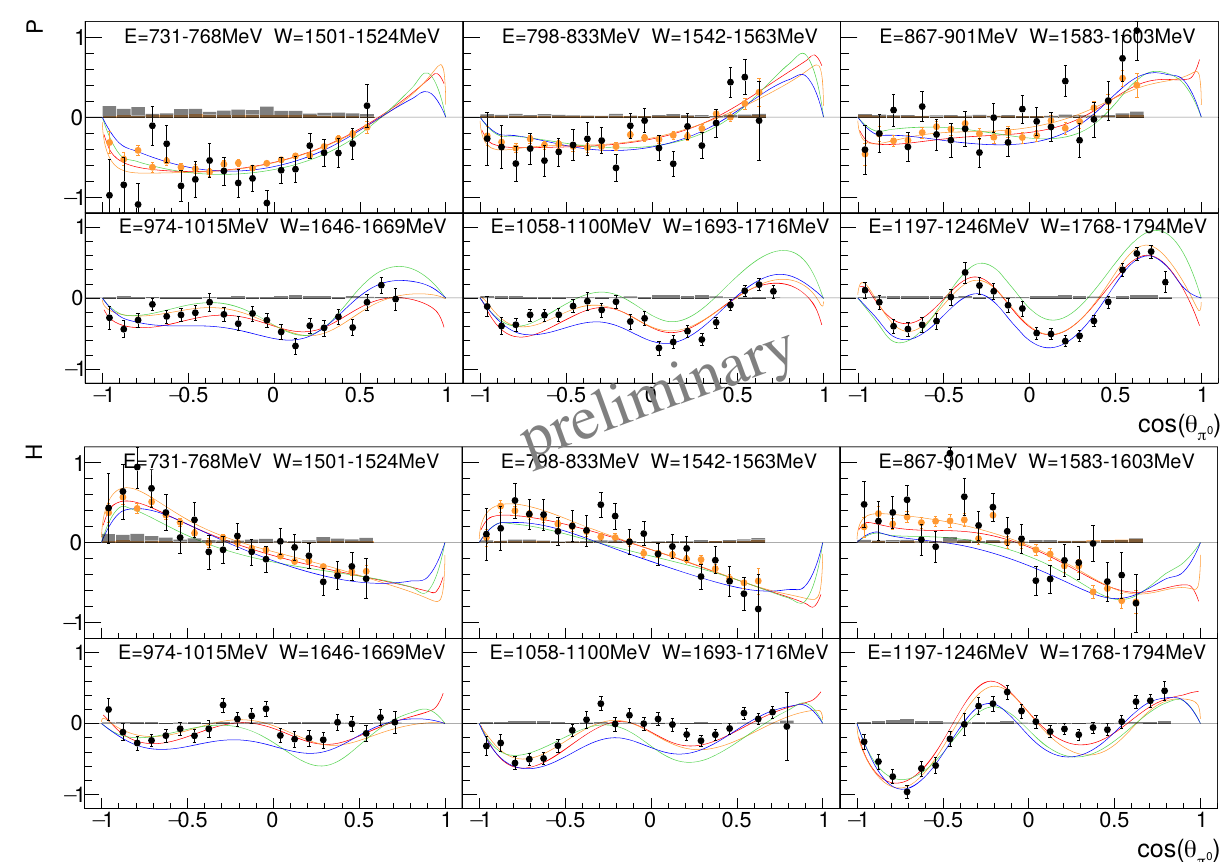
Figure 7. Preliminary results are shown for the polarization observables P and H for the p π 0 final state. This new data (black points), which was taken after the CB upgrade from December 2017 to October 2018, is compared to already published data of the CBELSA / TAPS collaboration [10, 11]. In addition, di ff erent PWA curves are plotted as well (JüBo-2017 (orange line) [16], BnGa- 2014-02 (red line) [15, 41], SAID-CM12 (blue line) [17] and MAID-2007 (green line)